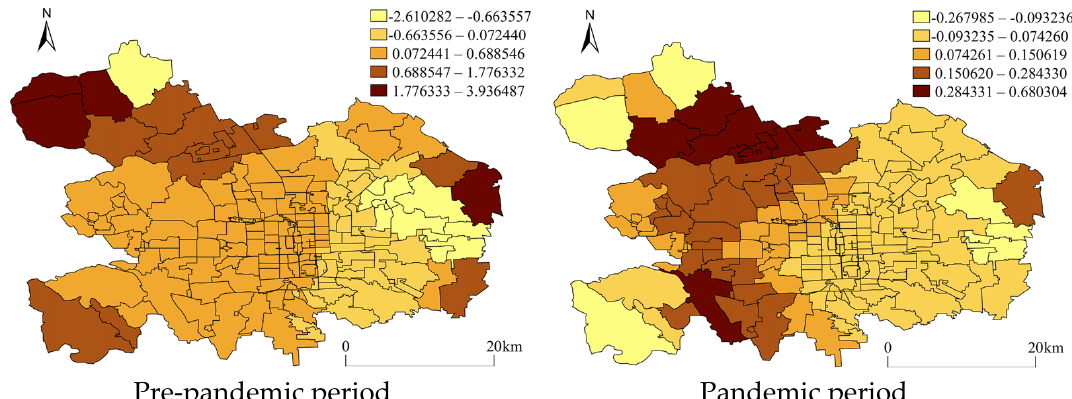
Figure 7. Coefficients of community clinics from GWR with non-motor vehicle theft. The coefficients were categorized by using natural breaks.